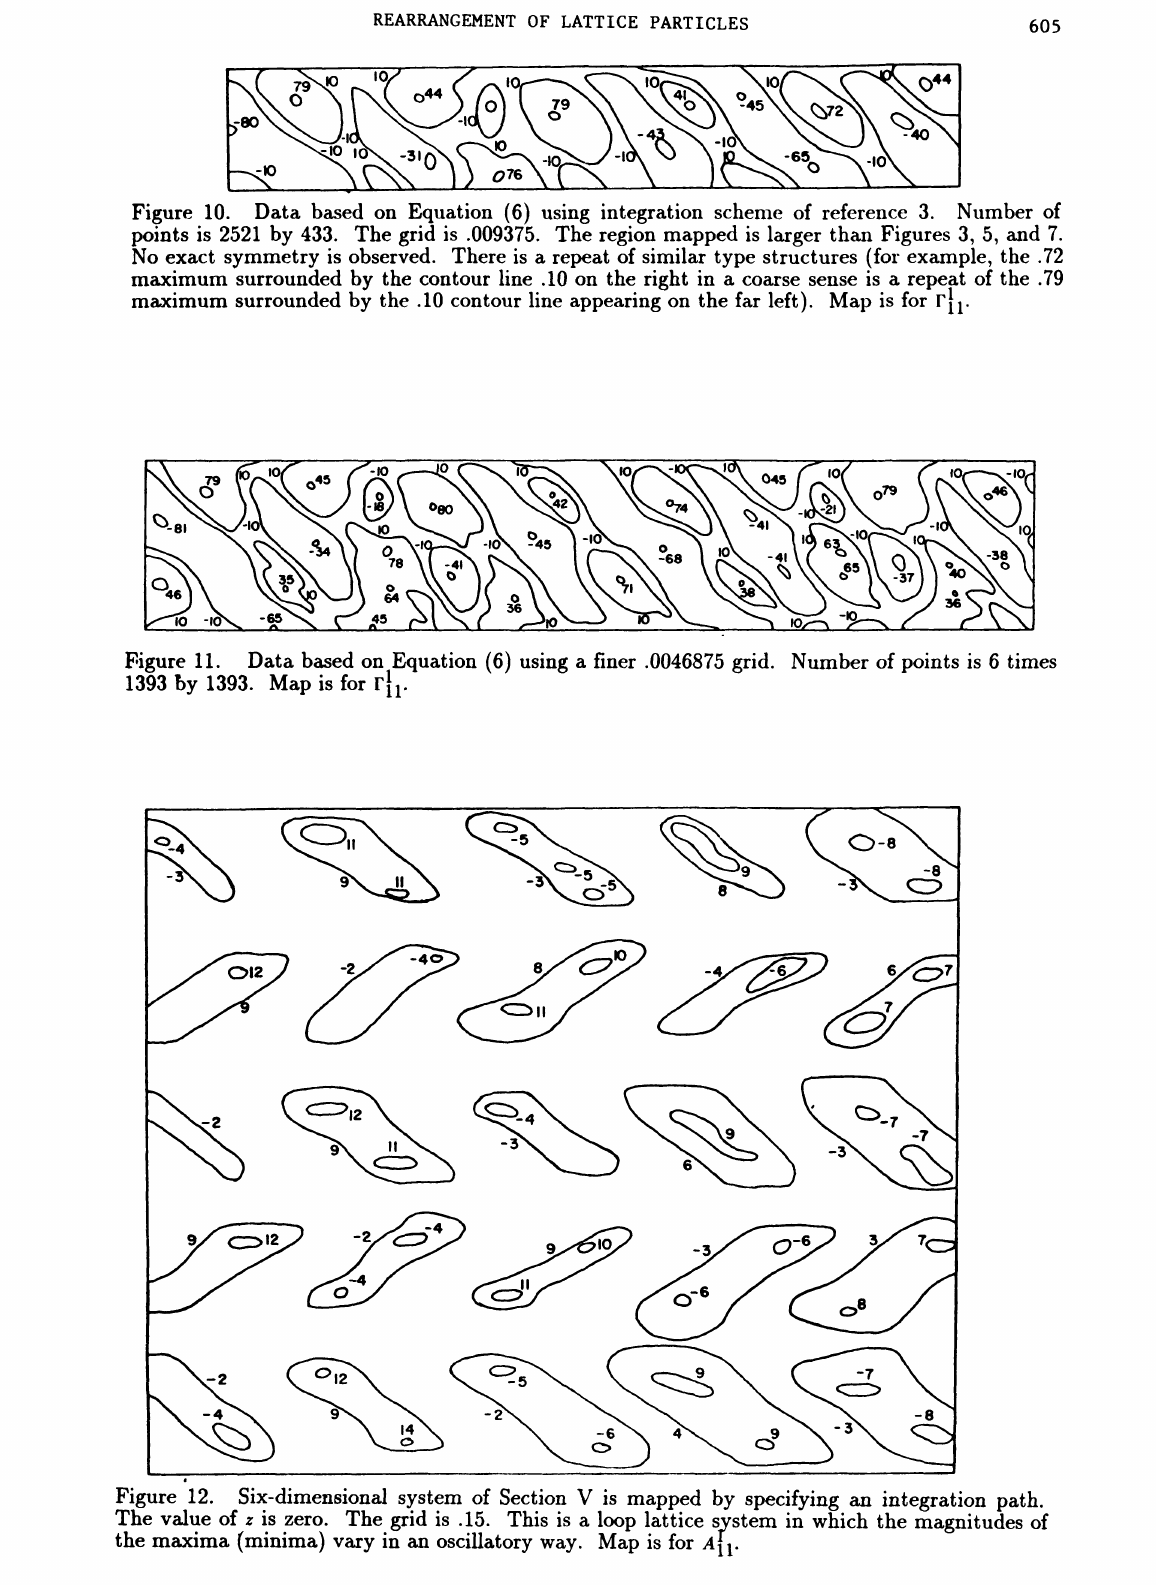
Figure 12. Six-dimensional system of Section V is mapped by specifying an integration path. The value of z is zero. The grid is .15. This is a loop lattice system in which the magnitudes of the maxima (minima) vary in an oscillatory way. Map is